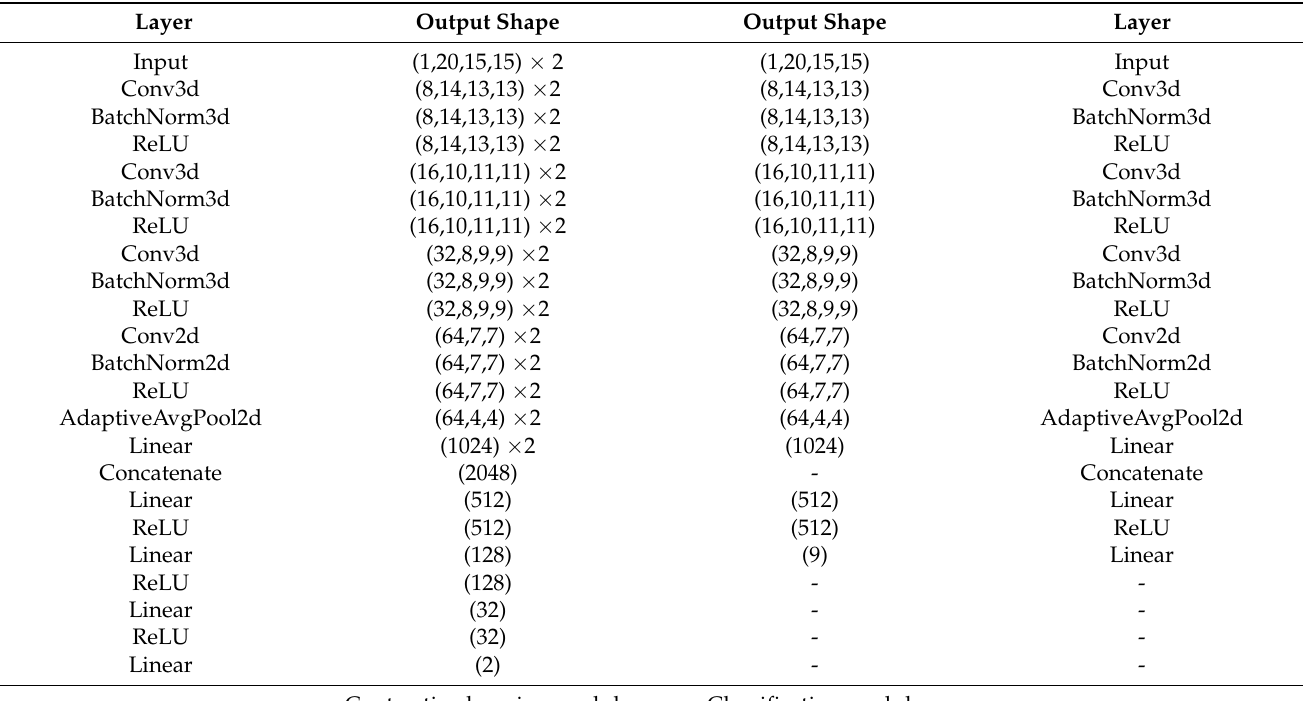
Table 1. Details of the dual learning-based siamese network (considering PaviaU dataset as an